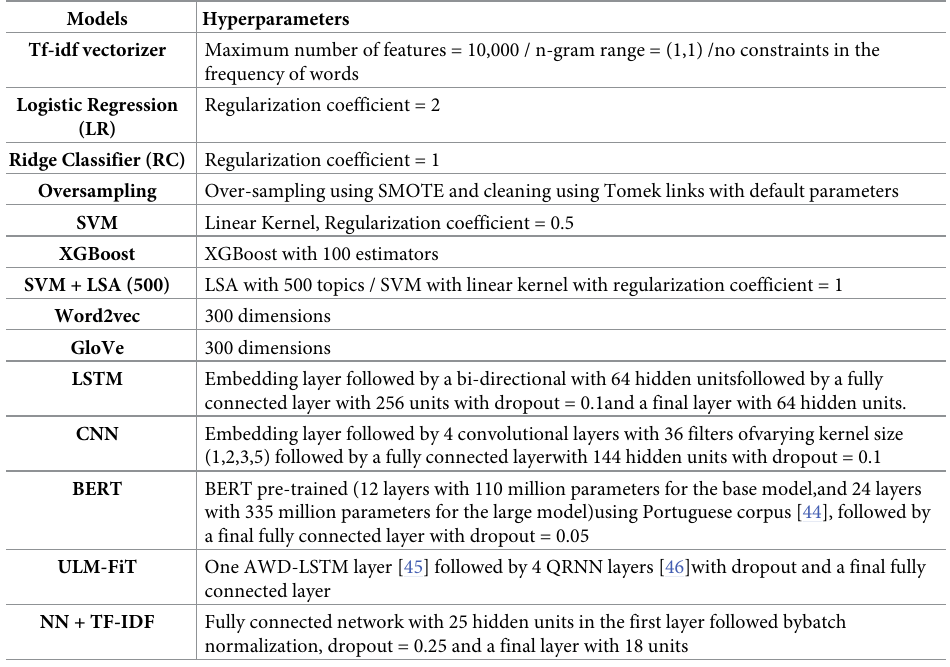
Table 2. Hyperparameters used to generate the